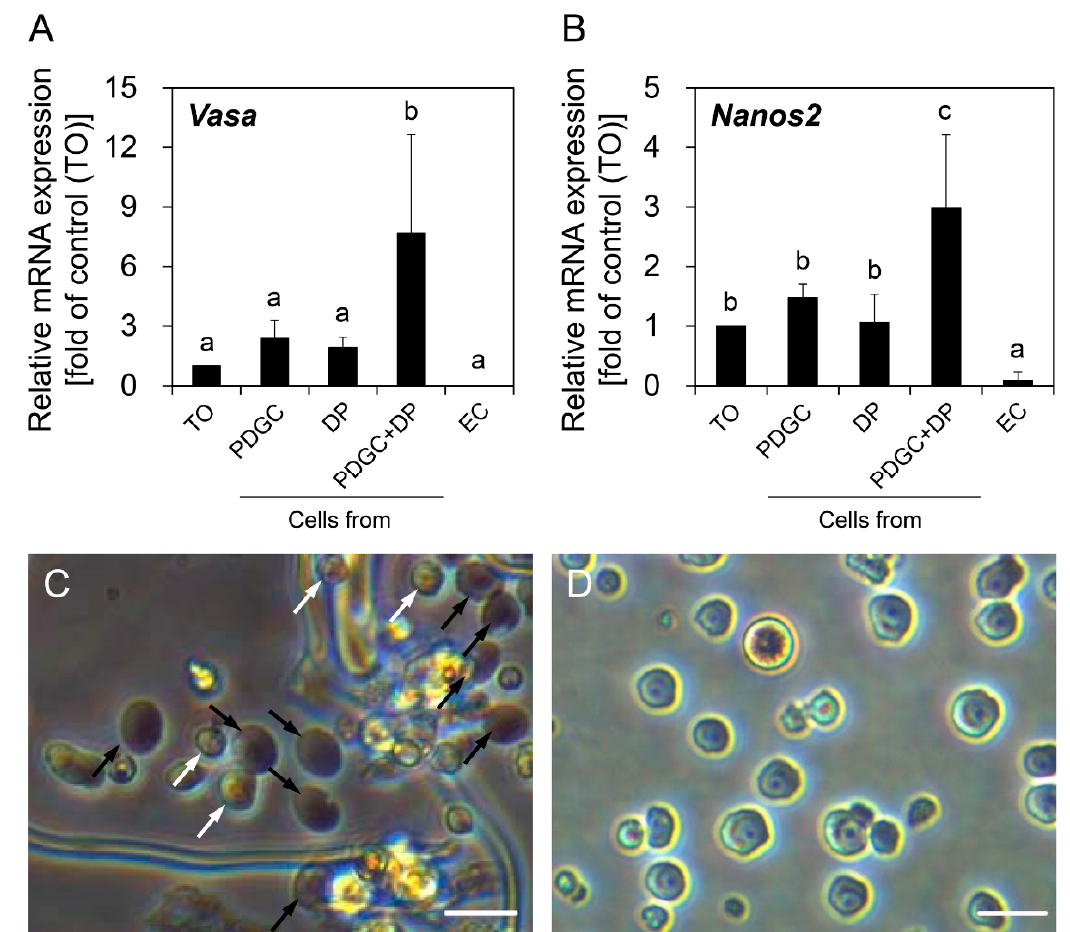
Figure 5. E ff ects of combinatorial use of PDGC and DP on the enrichment of OGSCs. qRT-PCR analysis for Vasa ( A ) and Nanos2 ( B ) genes to evaluate the enrichment e ff ect of the combinatorial use of PDGC and DP at the gene expression level. Crude TO was obtained from 10 adult females and separated by PDGC, Matrigel-based DP, or a combination of both. Cells from the 20–40% density fractions after PDGC and non-adherent cells after DP were used for analysis. In the combination of PDGC and DP, cells from the 20–40% density fractions after PDGC were subjected to Matrigel-based DP and the final non-adherent cells were used for analysis. Expression levels of Vasa and Nanos2 were significantly higher in the cells separated by PDGC and DP in combination compared to TO and the cells separated by PDGC or DP alone. Oryzias latipes EC were used as negative control. The values are expressed as mean ± SD. a–c Di ff erent letters indicate significant di ff erences; p < 0.05. ( C ) Morphology of the cells separated by only DP. Putative OGSCs (white arrowheads) and red blood cells (black arrowheads) were observed with tissue debris. ( D ) Morphology of the cells separated by PDGC and DP in combination. Remarkable enrichment of putative OGSCs was observed. Scale bars = 20 µm.